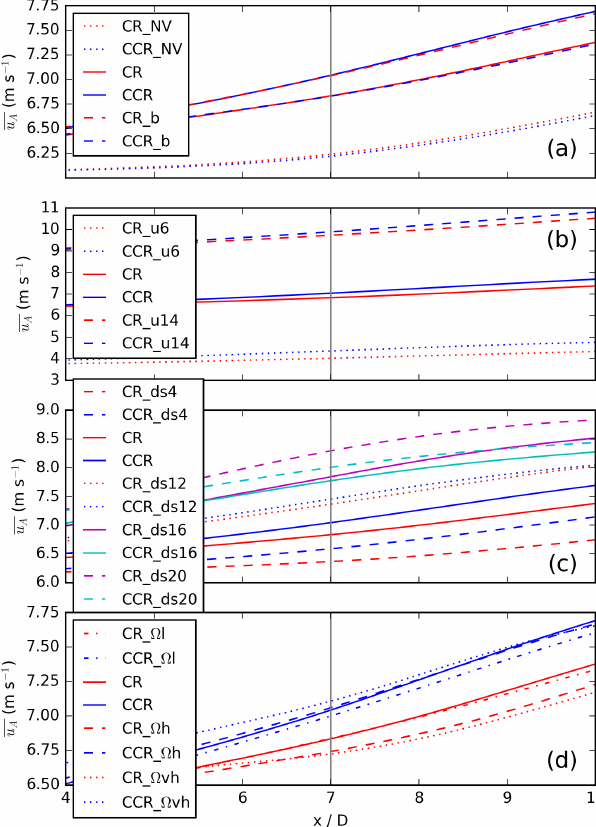
Figure 7. The rotor- and time-averaged streamwise velocity u A presented for a downwind region of [ 4 D, 10 D ] with special em- phasis at x = 7D for the simulations CR_NV, CCR_NV, CR, CCR, CR_b, and CCR_b in (a) ; for different geostrophic wind-values in (b) ; for different directional shears in (c) ; and for different ro- tational frequencies in (d)